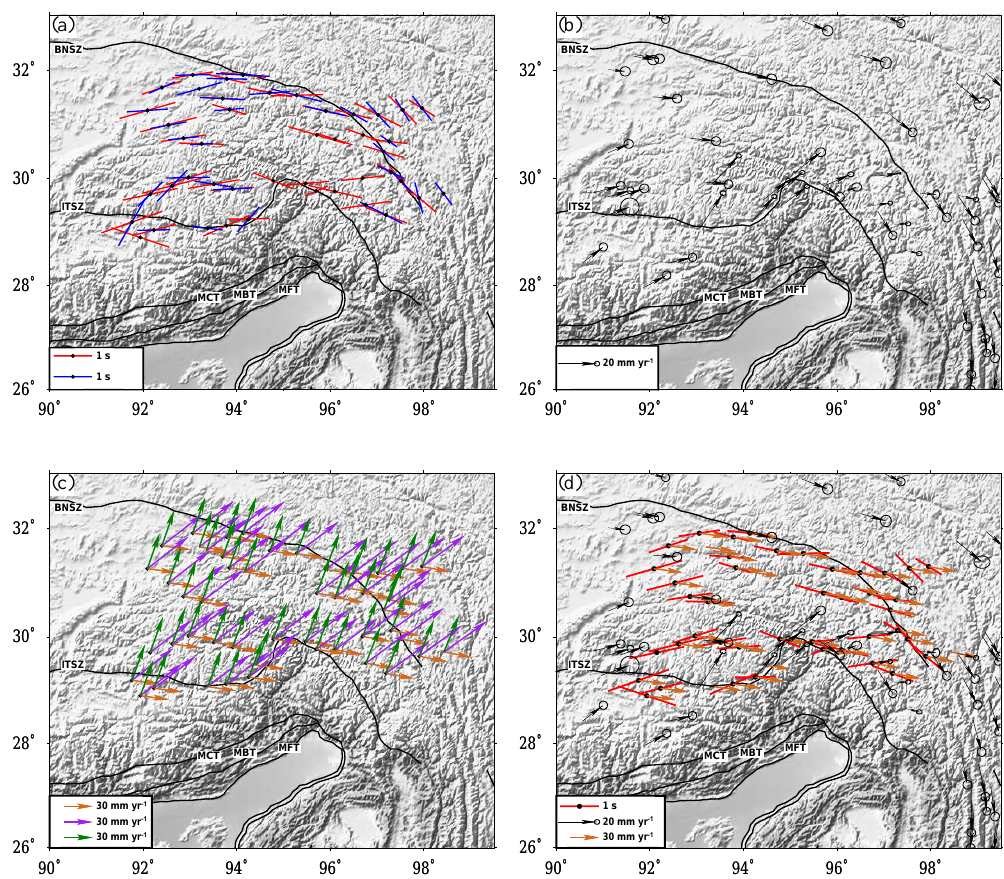
Figure 9. Lateral variations of anisotropic, geodetic, and absolute plate motion data shown over topographic and tectonic features of the study area. (a) Map view comparison between the splitting measurement inferred from direct S waves (this study shown by red bars) and SKS splitting measurements (Sol et al., 2007, in blue bars). (b) The Global Positioning System (GPS) velocity (mmyr − 1 ) vectors (black arrows) around SE Tibetan region calculated with respect to the South China reference frame and stable Eurasia. GPS data is compiled from several studies including Chen et al. (2000), Zhang et al. (2004), Shen et al. (2005), and Sol et al. (2007). (c) Absolute plate motion (APM) velocities calculated through https://www.unavco.org/software/geodetic-utilities/plate-motion-calculator/platemotion-calculator.html by us- ing the GSRM v1.2 (2004) model of Kreemer et al. (2003). Note that arrows in brown, green, and purple represent the APM velocities of the Eurasian Plate in no net rotation frame, of the Indian Plate with respect to the Eurasian Plate, and the motion of the Indian Plate in no net rotation frame, respectively. (d) Map view comparisons of the station (black circle) average direct S -wave-derived splitting parameters with GPS velocity (black arrow) and APM (brown arrow) vectors. Abbreviations on the maps: MFT: Main Frontal Thrust; MBT: Main Boundary Thrust; MCT: Main Central Thrust; ITSZ: Indus–Tsangpo suture zone; BNSZ: Bangong–Nujiang suture zone; JRSZ: Jinsa River suture